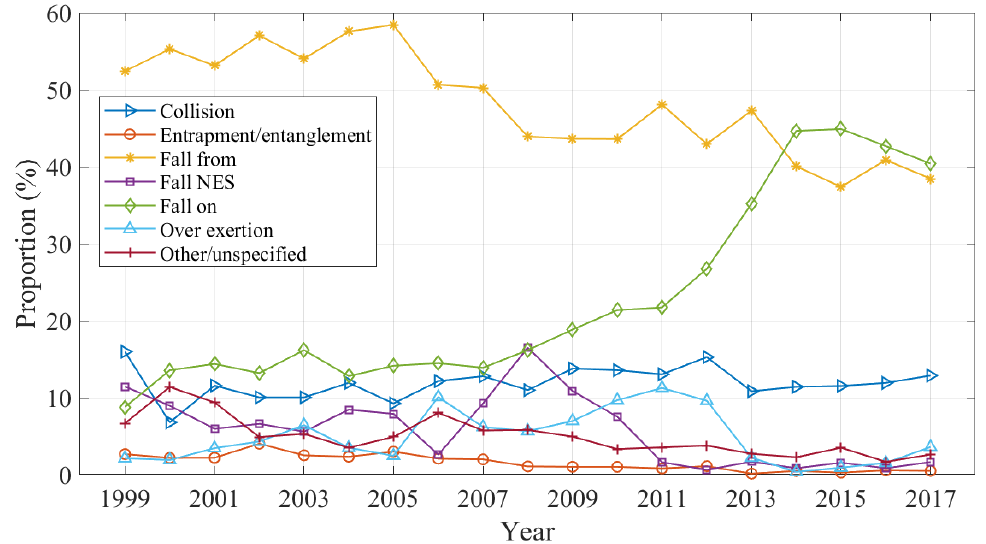
Figure 3. Proportion of injuries by